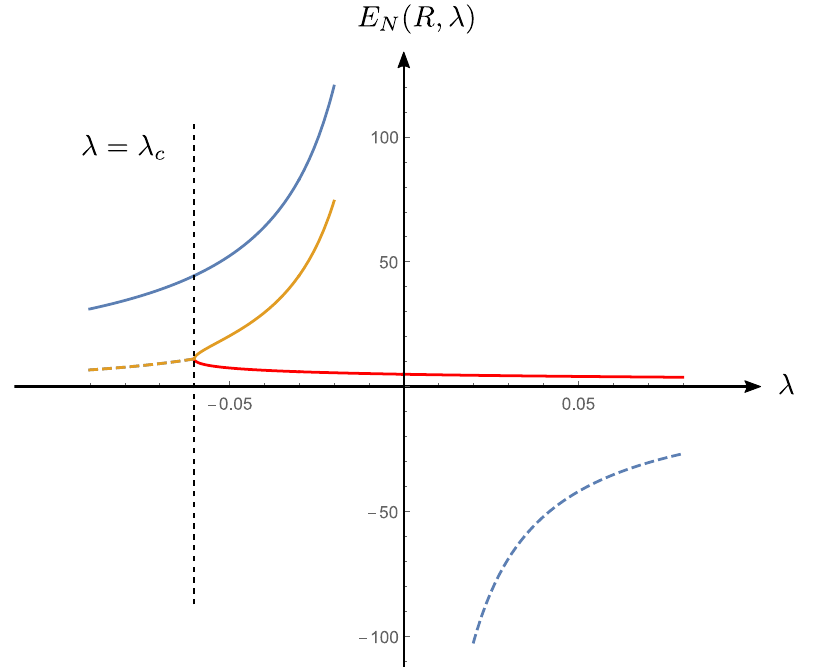
Figure 3: Plot of the zeros of f ( x ) = 0. The solid lines represent the real values, the dashed lines represent the real part of the complex values. We see that in the regime λ ≥ λ (the red line) we can identify the deformed spectrum c